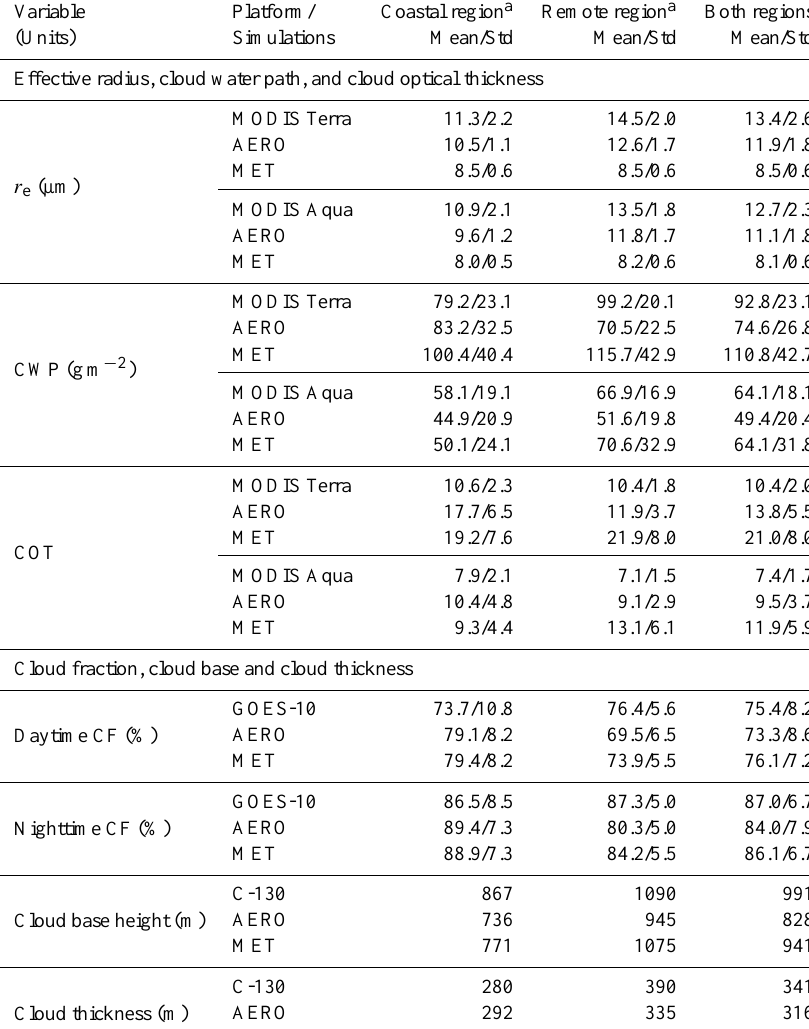
Table 5. Observed and simulated cloud